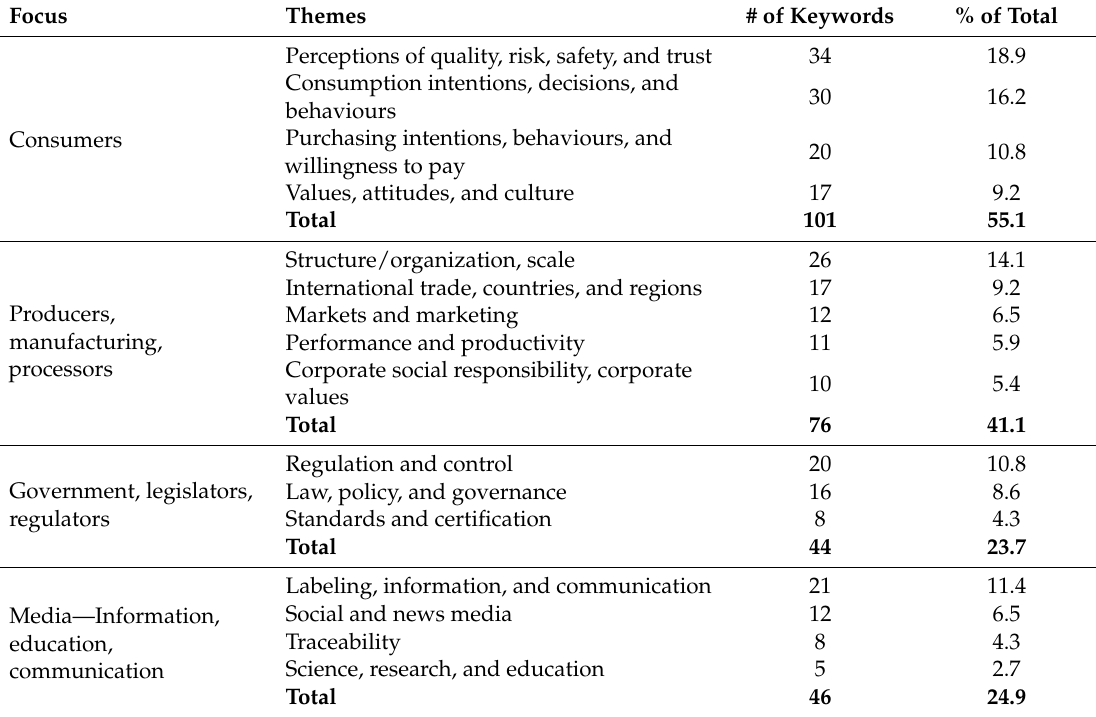
Table 6. Selected themes by food safety system